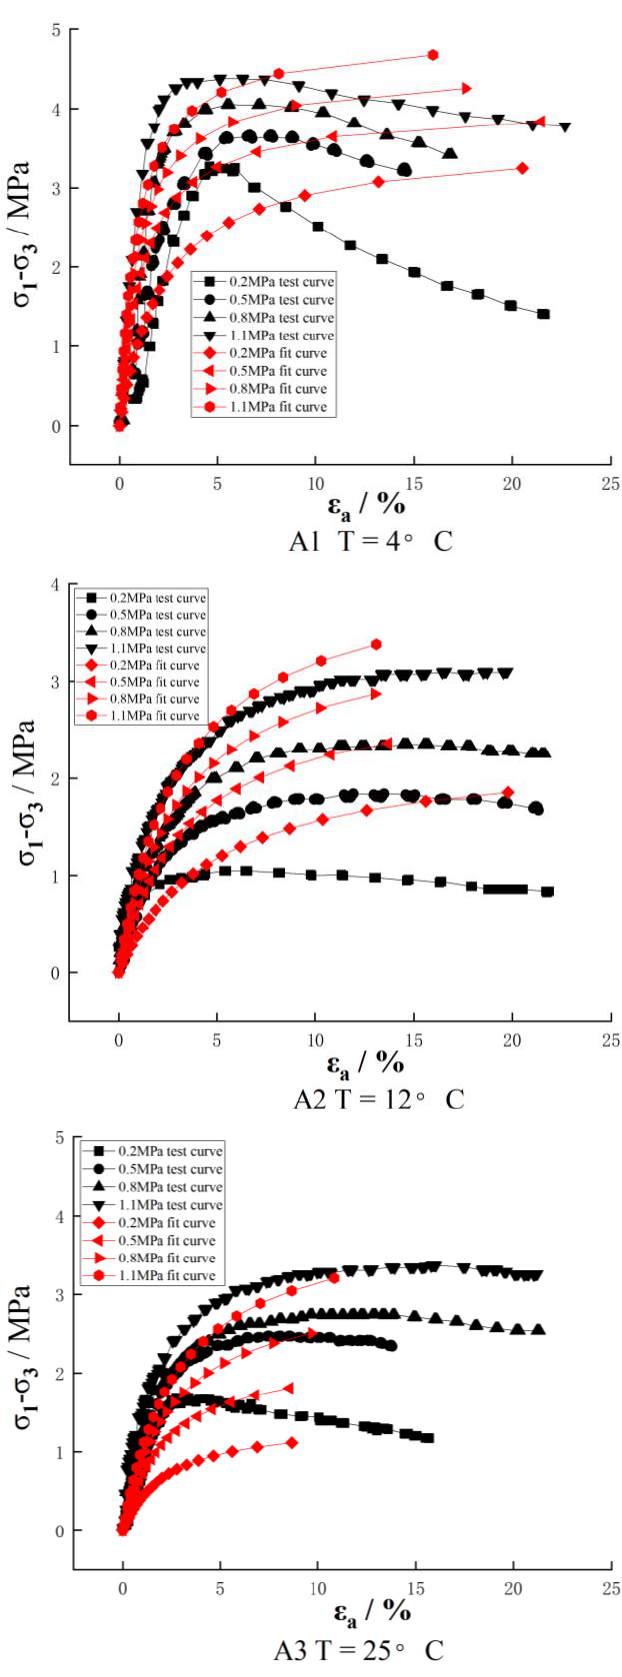
Figure 5. The fitting results are compared with the experimental results.